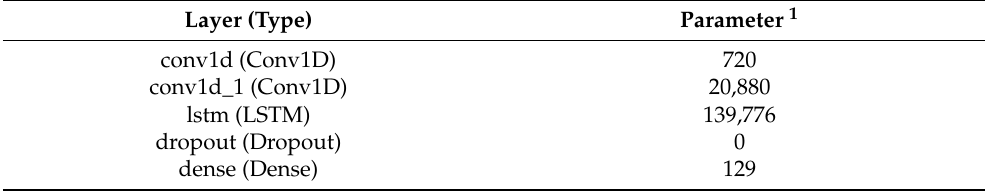
Table 1. Model parameter table.